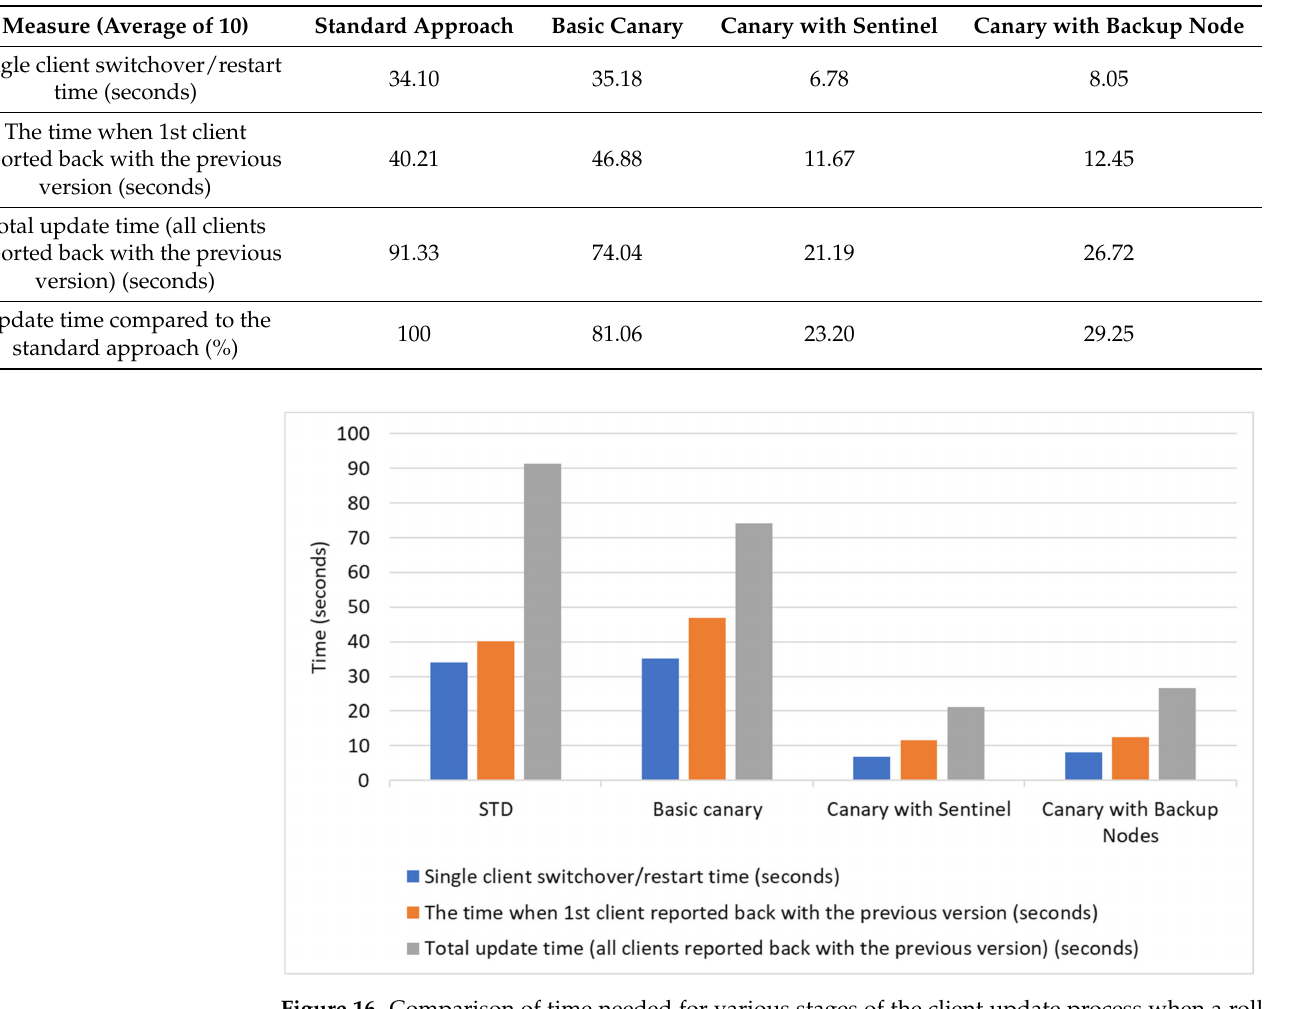
Figure 16. Comparison of time needed for various stages of the client update process when a roll back is